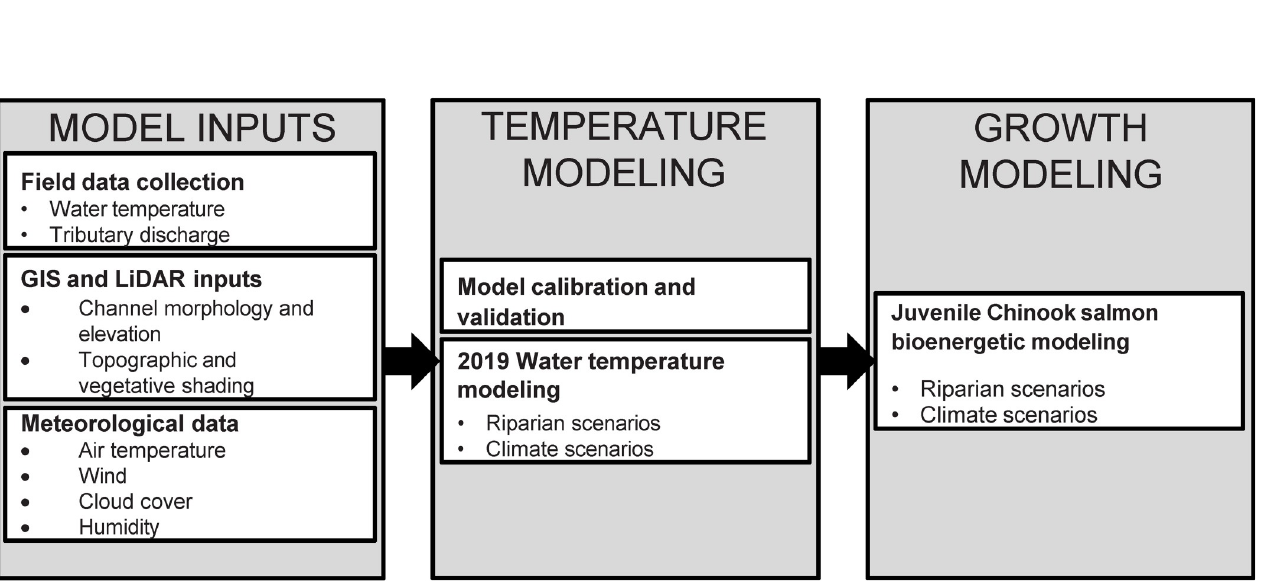
Fig 2. Modeling framework. Conceptual diagram of modeling of inputs needed to run, parameterize, and link temperature and growth modeling.